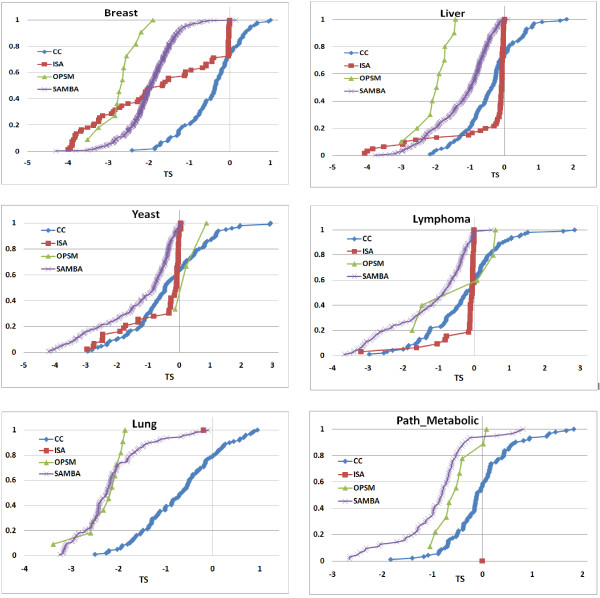
Stratification of biclusters. Cumulative distribution TS1(b) of the biclusters from each algorithm on 6 datasets. Highly negative TS1(b) (< -1) shows B-type co-expression, highly positive TS1(b) (> 1) shows T-type co-expression and TS1(b) close to zero (-1< TS1(b) <1) indicates μ-type co-expression.